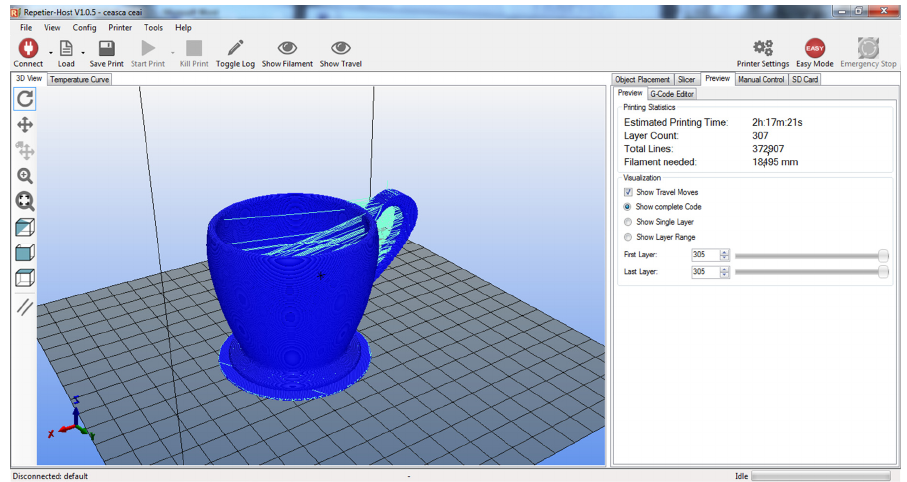
Figure 12. Cura environment interface: final solution.